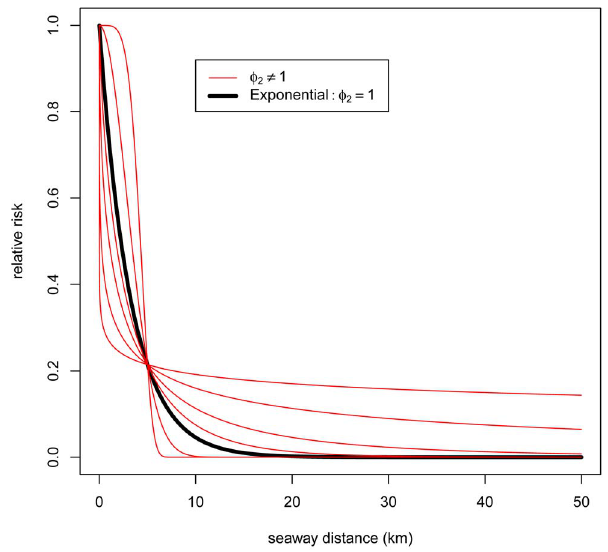
Figure 3. A selection of possible shapes for the relative effect of the seaway distance for various values of the w 2